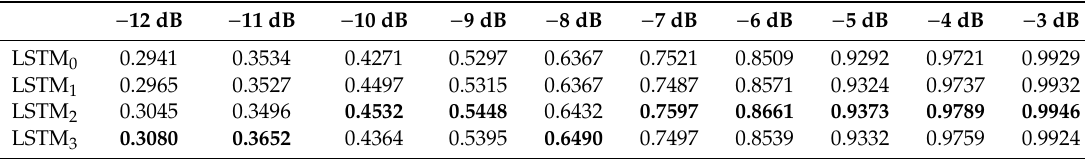
Table 2. Performance of di ff erent LSTM layers with a varying